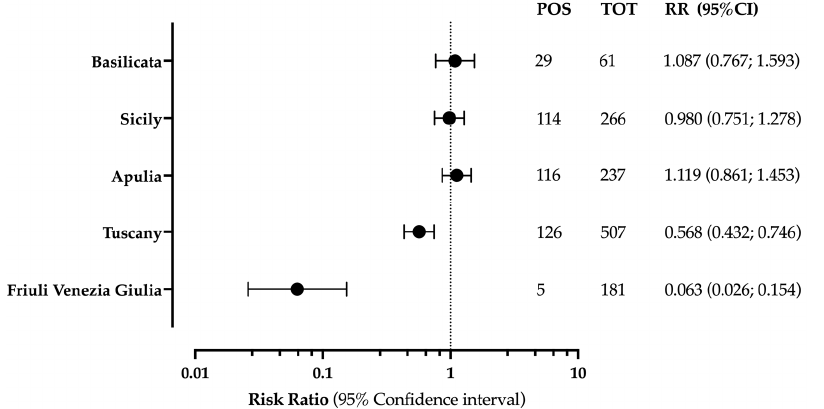
Figure 5. Forest plot representing risk ratio on main occupational groups by parent Italian region, and assuming Lombardy region (42 positive cases over a total of 96 samples; 43.8%) as the reference one. Note: RR = Risk Ratio; 95%CI = 95% Confidence Interval.